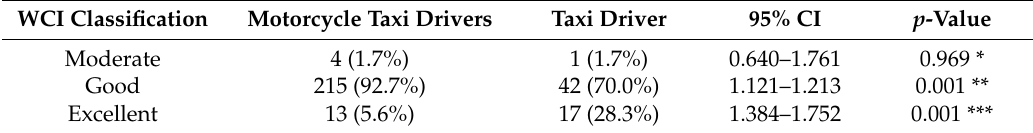
Table 3. Comparisons of the WCI classifications between motorcycle taxi drivers and taxi